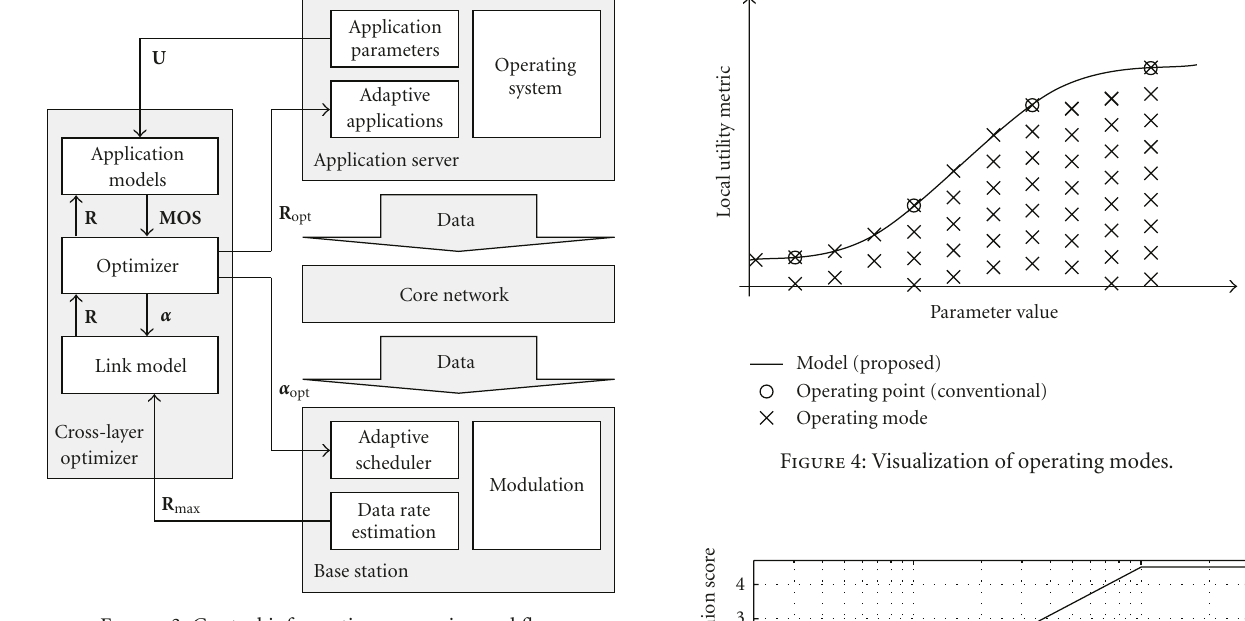
Figure 3: Control information processing and flow.